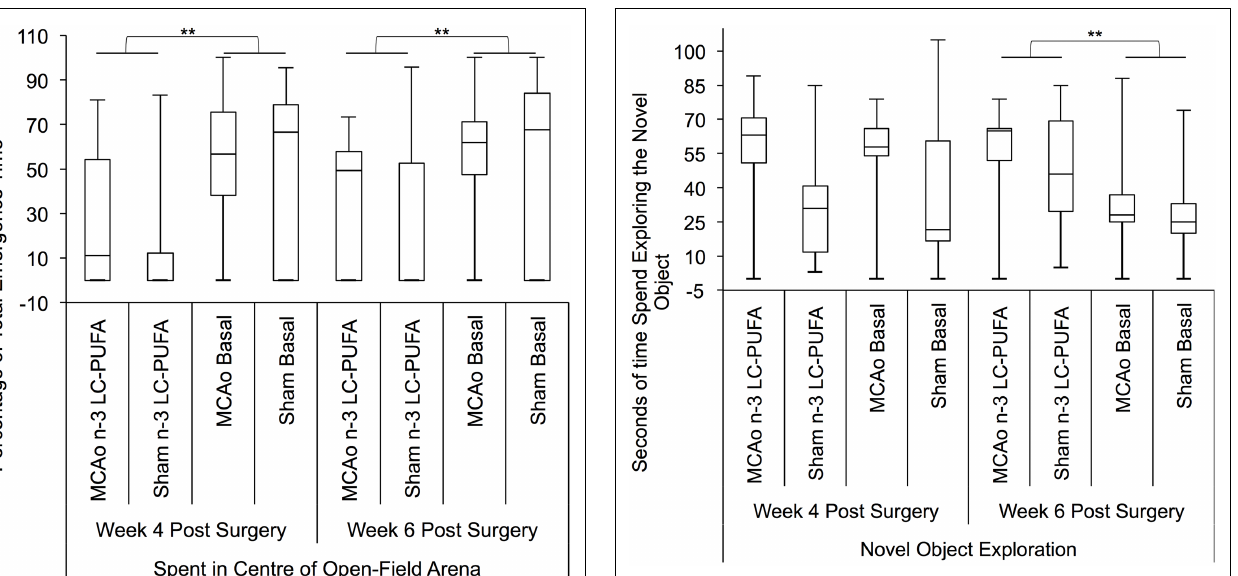
FIGURE 8 | Box plots showing significant post hoc differences in percentage of total emergence time spent in center of open field, compared to the side wall of the open-field arena, between diet and surgery conditions .Visual inspection of this figure indicates that n -3-LC-PUFA diet fed animals spent more time in the center of the arena, than did basal diet fed animals. No effects of surgery condition on percentage of time spent in the center of the arena can be seen. MCAo, middle cerebral artery occlusion surgery condition; Sham, Sham surgery condition; Basal, basal diet fed rats; n -3-LC-PUFA, polyunsaturated fatty acid supplemented rats. n = 11 n -3-LC-PUFA MCAo; n = 13 Basal MCAo; n = 12 n -3-LC-PUFA sham; n = 12 Basal Sham.